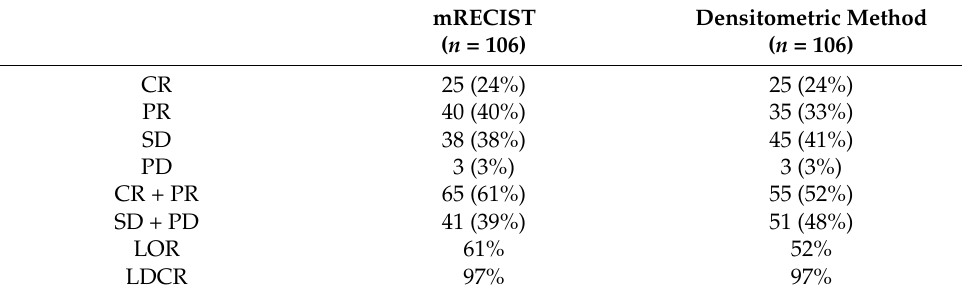
Table 2. Response class rate, LOR, and LDCR for lesions evaluated with mRECIST and the densito- metric method. The local analysis disregarded possible progression in non-target lesions or due to the appearance of new